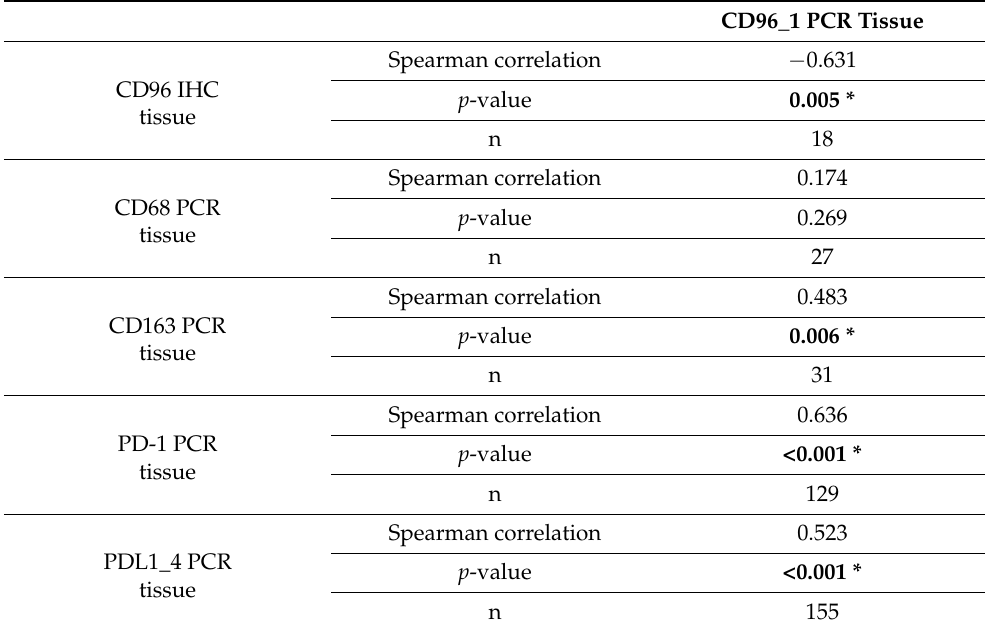
Table 5. Correlation of CD96_1 tissue with CD96 IHC, CD68, CD163, PD-1, and PDL1_4 expression in tissue